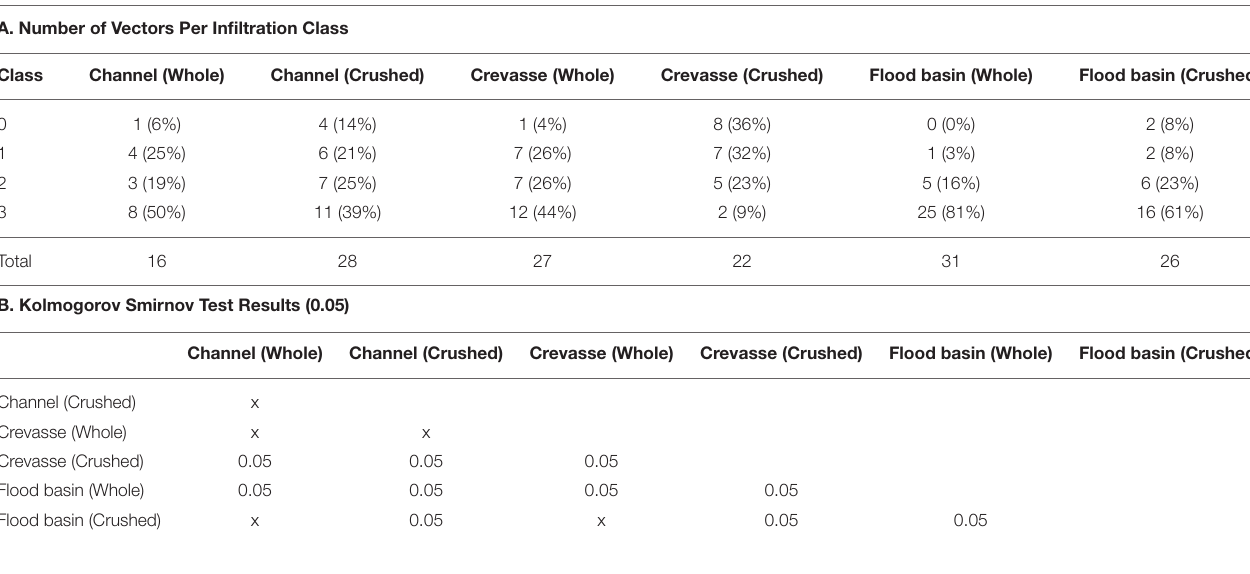
TABLE 3 | Kolmogorov Smirnov Goodness of Fit results: (A) number of natural osteological vectors tallied with Class of biofilm infiltration; (B) results of significant difference